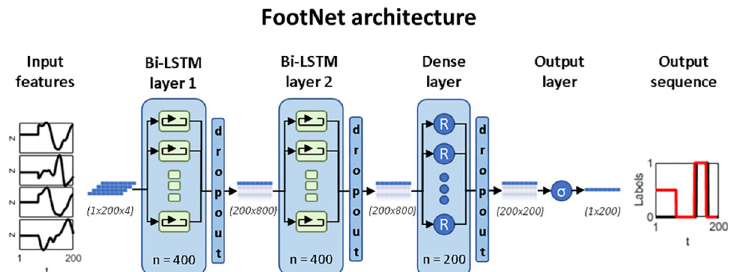
Fig 3. FootNet architecture. FootNet takes the distal tibia anteroposterior velocity, ankle plantar/dorsiflexion angle and the foot COM anteroposterior and vertical velocities as input and produces a sequence of probabilities of non- contact (0) and contact (1). Note that the input features are first standardised (z scores), 0-padded at the start of the sequence to a standard length of 200 data-points and concatenated into a 1x200x4 array where 1 is the number of cycles, 200 is the number of timepoints and 4 is the number of input features. Zero padding was added to batch the training cases and 200 was selected as a sufficient number of timepoints to accommodate a stride cycle at any of the tested speeds. The padding is ignored during training, hence the 0.5 values at the beginning of the output sequence.